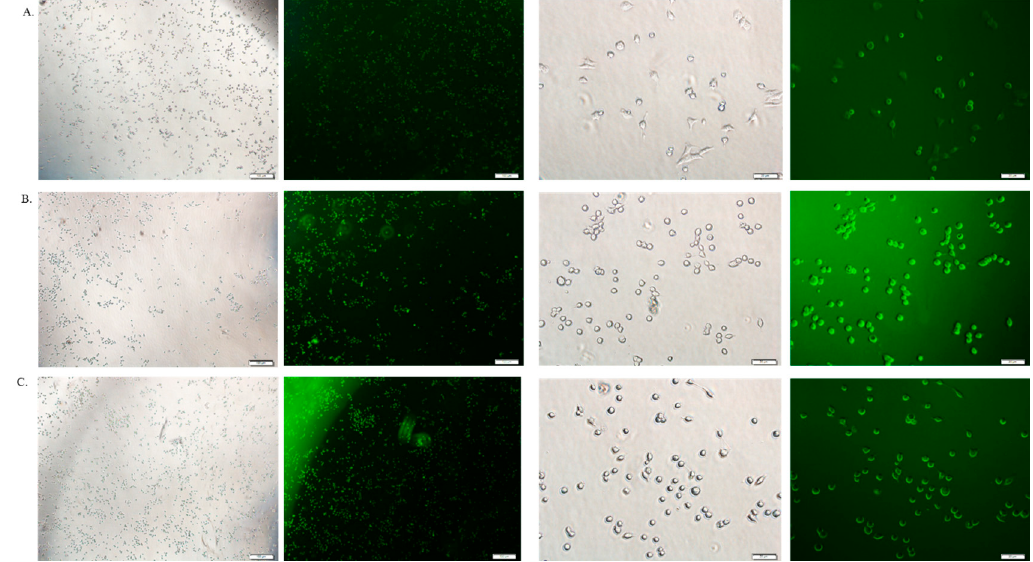
Figure 10. Fluorescence image analysis of MCF-7 cells incubated with DOX 5 µM ( A ), DOX-loaded CA NPs (5 µM); ( B ) and DOX-loaded CMCA NPs (5 µM); ( C ) at 37 °C for 1 h with 4× and 20× magnifications at a scale bar of 100 µm and 20 µm.